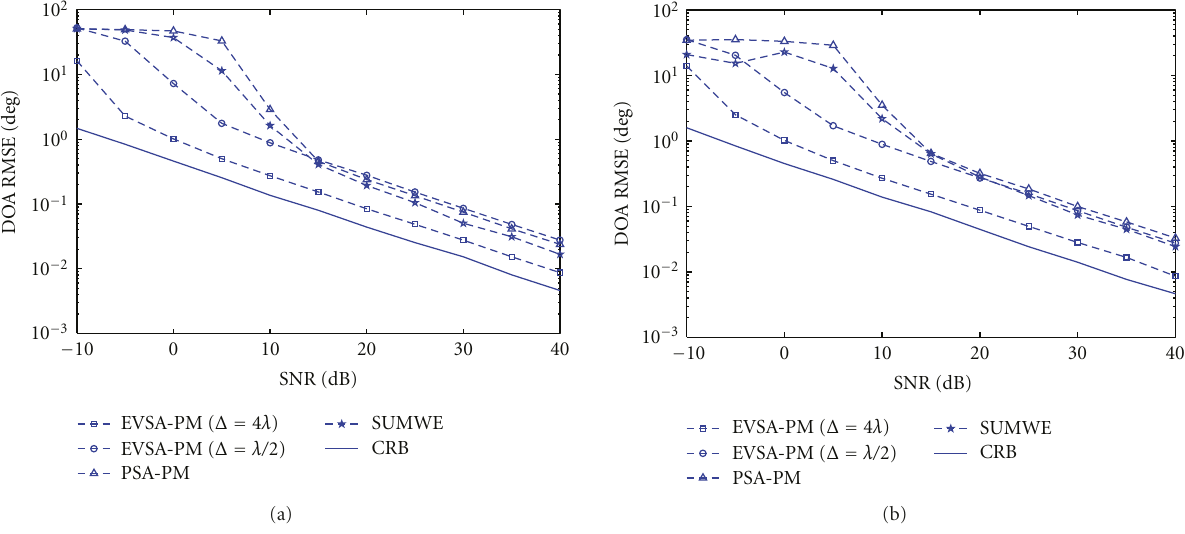
Figure 3: DOA estimate RMSEs of EVSA-PM, PSA-PM, and SUMWE against SNRs. (a) Source 1, (b) source